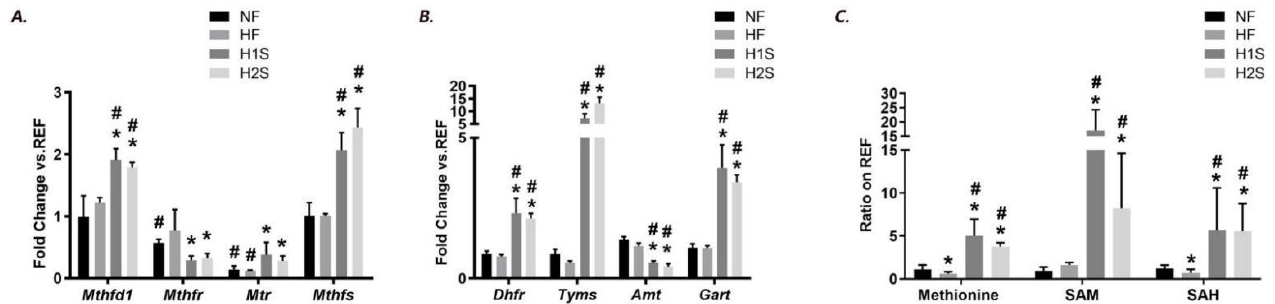
Figure 2. Maternal one-carbon supplementation corrected and overloaded the disrupted methionine cycle by maternal HF diet. ( A ) Gene expression levels of Mthfd1, Mthfr, Mtr, and Mthfs were measured by real-time PCR in the male offspring livers. ( B ) Gene expression levels of Dhfr, Tyms, Amt, and Gart were measured by real-time PCR in the male offspring livers. ( C ) Methionine, SAM and SAH contents were detected via high-resolution UPLC-MS/MS. Data are presented as the mean ± SE, n = 5 . * indicates p < 0.05 vs. the NF group. # indicates p < 0.05 vs. the REF group.